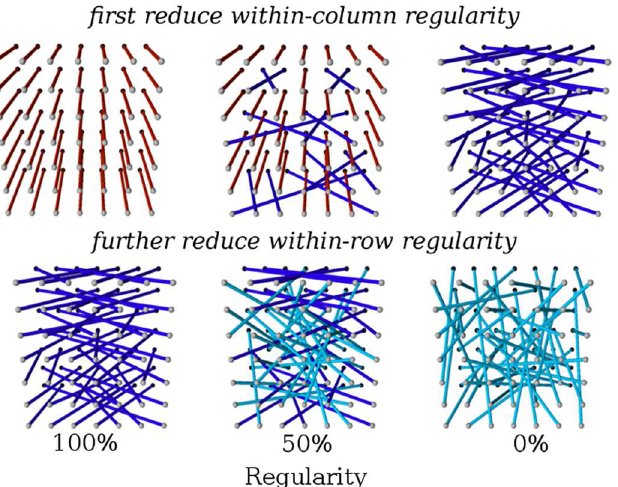
Fig 11. Adjusting the regularity of the bit mirroring experiment. Completelyregular target networks for the bit mirroring experiment directly mirror bits from input layer nodesto correspondingnodesin the same row and column of the output layer. Regularity is decreased by first releasingthe constraint that nodes connect within the same column, then by releasingthe constraint that nodesconnect within the same row. Red links are row-and-column constrained, blue links are row constrained, and light blue links are unconstrained. Adapted from [24].